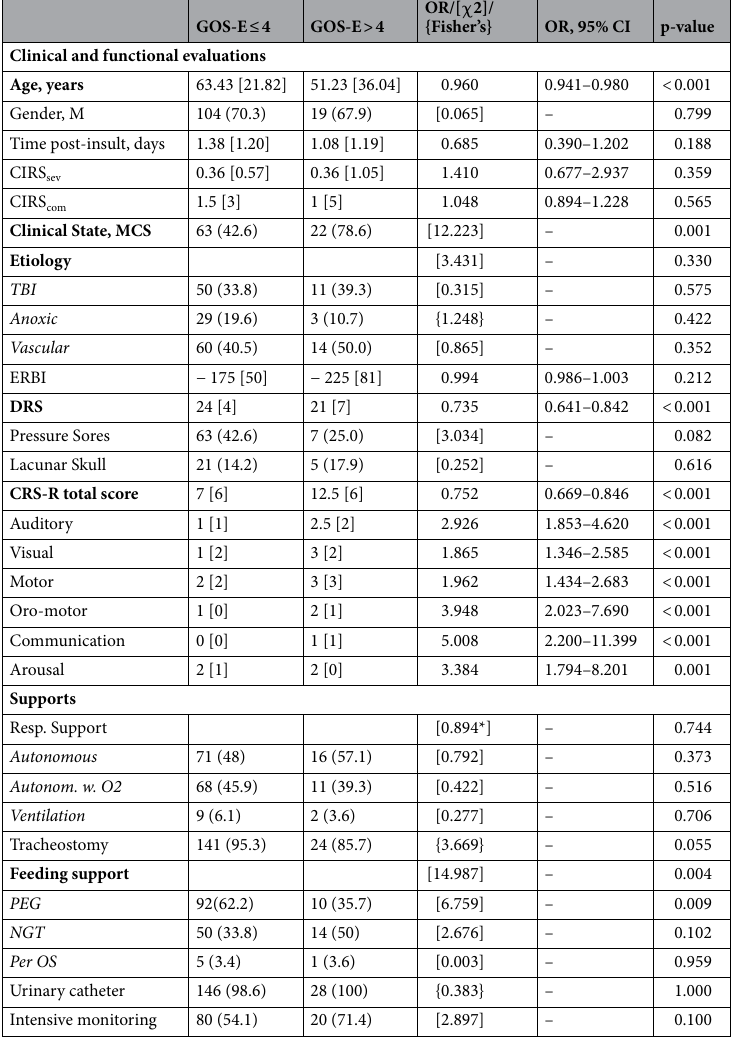
Table 1. Admission descriptive and inferential statistics for admission variables. CIRS: Cumulative Illness Rating Scale, MCS Minimally Conscious State, TBI Traumatic Brain Injury, ERBI Early Rehabilitation Barthel